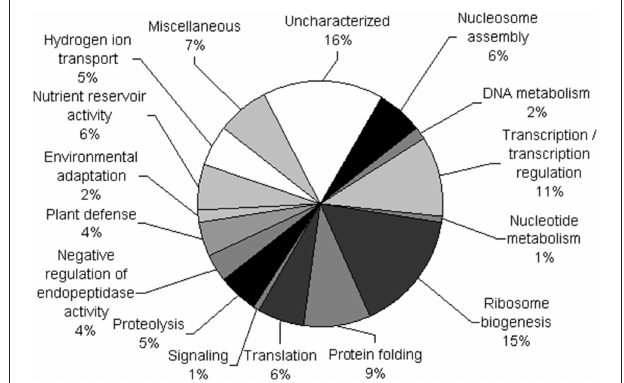
FIGURE 3 | Functional classification of nuclear proteins. The 114 different proteins identified were grouped into 16 functional classes according to the KEGG pathway database and gene ontology (GO). The percentage of proteins in each functional class is shown.